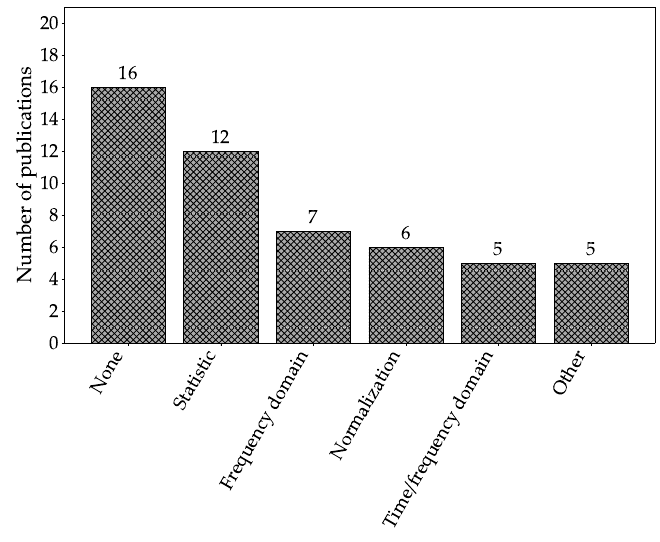
Figure 10. Repartition of pre-processing for ANN techniques.